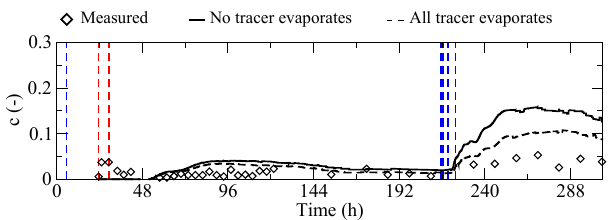
Figure 7. Measured and modeled average tracer concentration at the seepage face for the cases in which no tracer and all tracers leave the system with evaporation (simulations i and k of Table 3). Both simulations are run for α l = 0 . 001m and α t = 0 . 0001m. The vertical dashed lines indicate the timing of the three pulses of rain (red when the water is 2 H -enriched and blue when it is not).